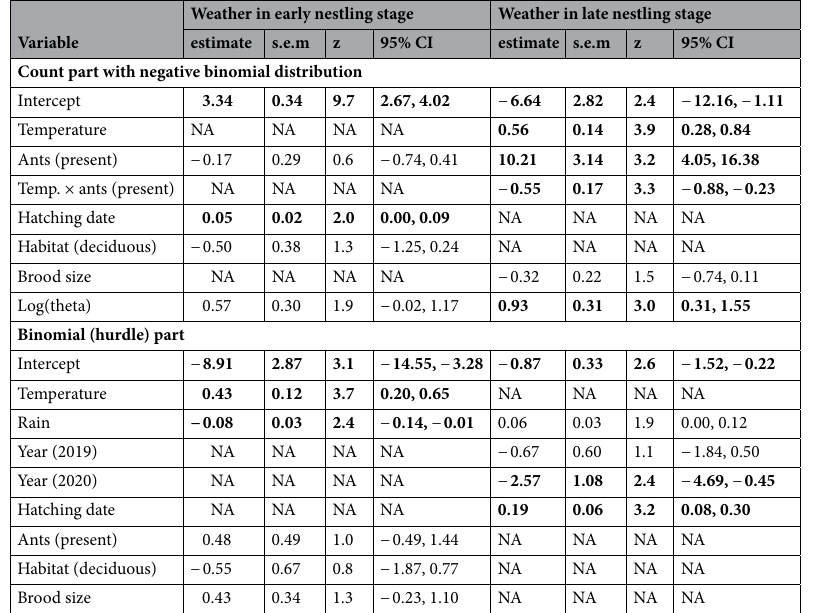
Table 2. Model-averaged covariates best explaining the number of blowflies in infested nests of Wood Warblers (count), and the likelihood of blowfly presence (binomial) in nests (package pscl 92,93 ). Shown are (conditional) model-averaged coefficients and confidence intervals (CI) across top models (ΔAICc < 2) with different sets of covariates on count and binomial parts (Table 1). Significant relationships ( P < 0.05) are marked in bold; NAs—covariates dropped during model selection (present in models with ΔAICc ≥ 2).